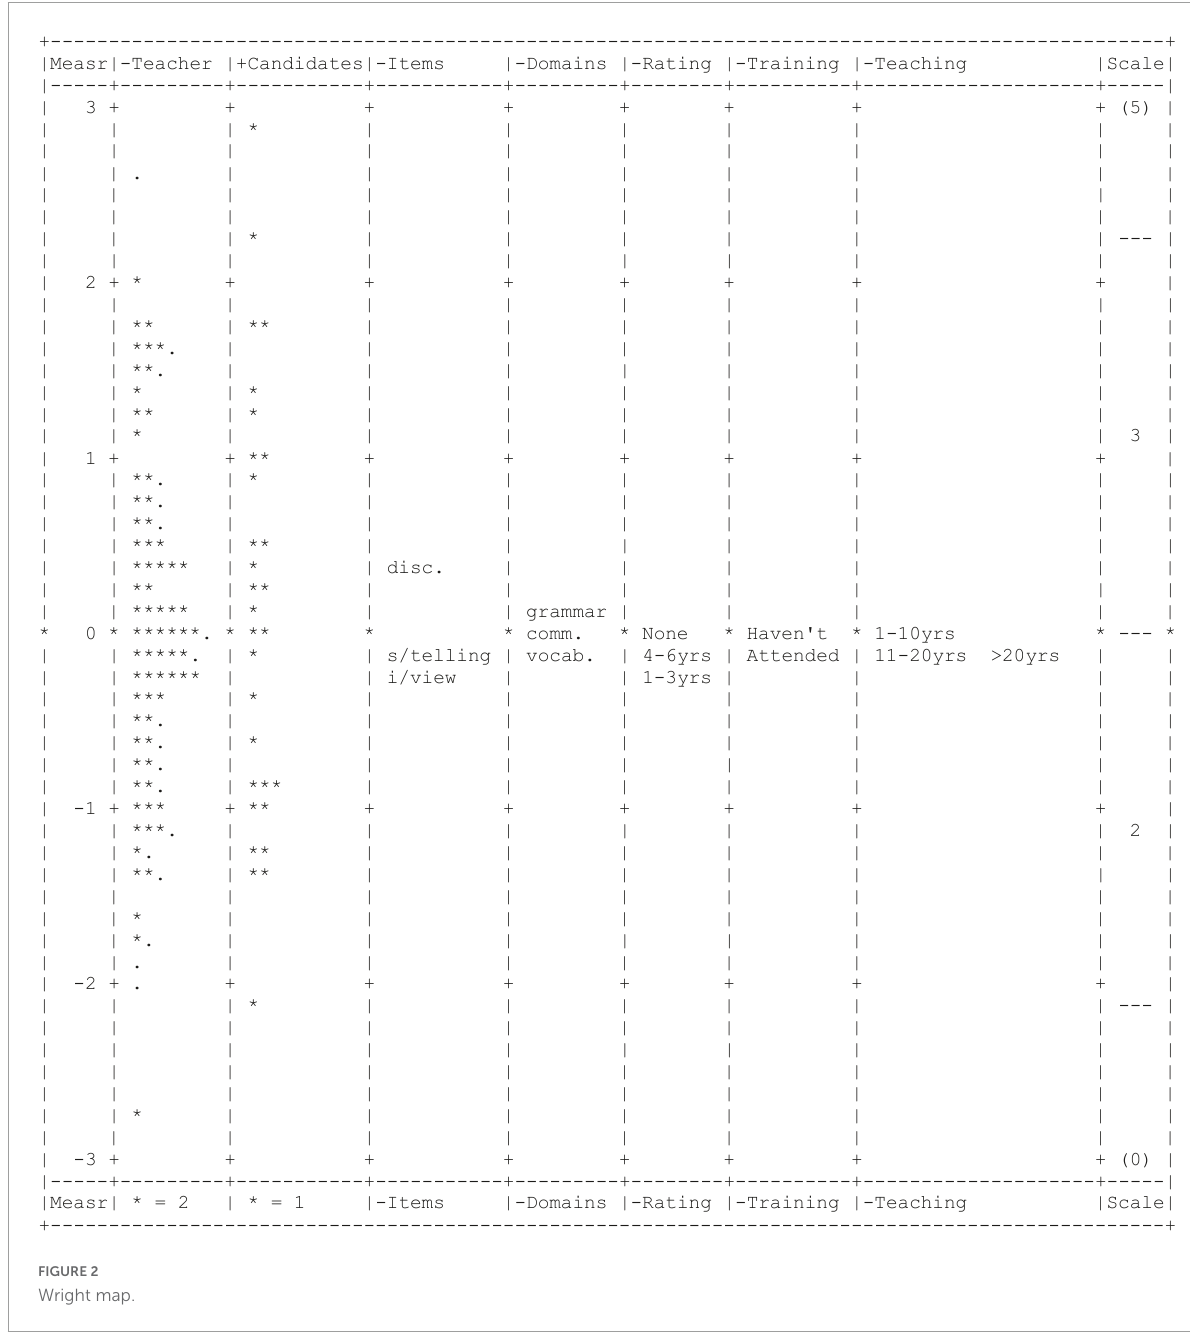
|-Domains |-Rating |-Training |-Teaching